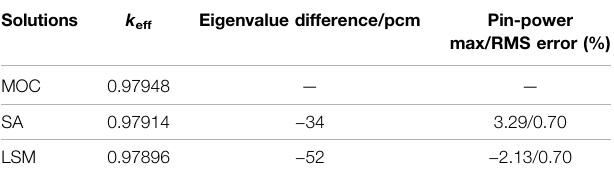
TABLE 4 | Summary of the